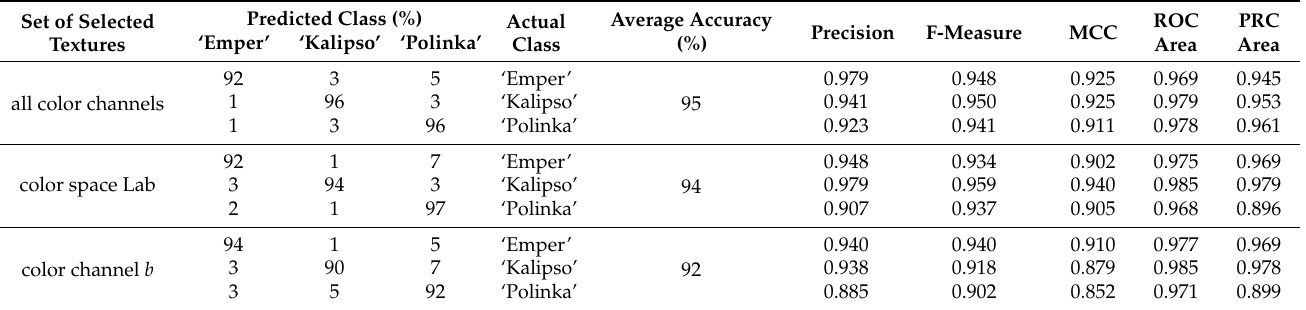
(Table 3). The individual cultivars were discriminated with the accuracies from 92 (‘Emper’) to 96% (‘Kalipso’, ‘Polinka’) for the model developed for textures from all color channels, 92 (‘Emper’) to 97% (‘Polinka’) for color space Lab and 90 (‘Kalipso’) to 94% (‘Emper’) for color channel b . The Precision, F-Measure, MCC, ROC Area, PRC Area, reached 0.979 (‘Emper’, all color channels and ‘Kalipso’, color space Lab), 0.959 (‘Kalipso’, color space Lab), 0.940 (‘Kalipso’, color space Lab), 0.985 (‘Kalipso’, color space Lab, color channel b ), 0.979 (‘Kalipso’, color space Lab), respectively. The course of ROC curves was the smoothest in the case of the ‘Kalipso’ plum kernels (Figure 4). Table 3. The results of cultivar discrimination of plum kernels performed using models built based on textures selected from all color channels L , a , b , R , G , B , U , V , S , X , Y , Z , color space Lab, and color channel b using the LMT (Trees)